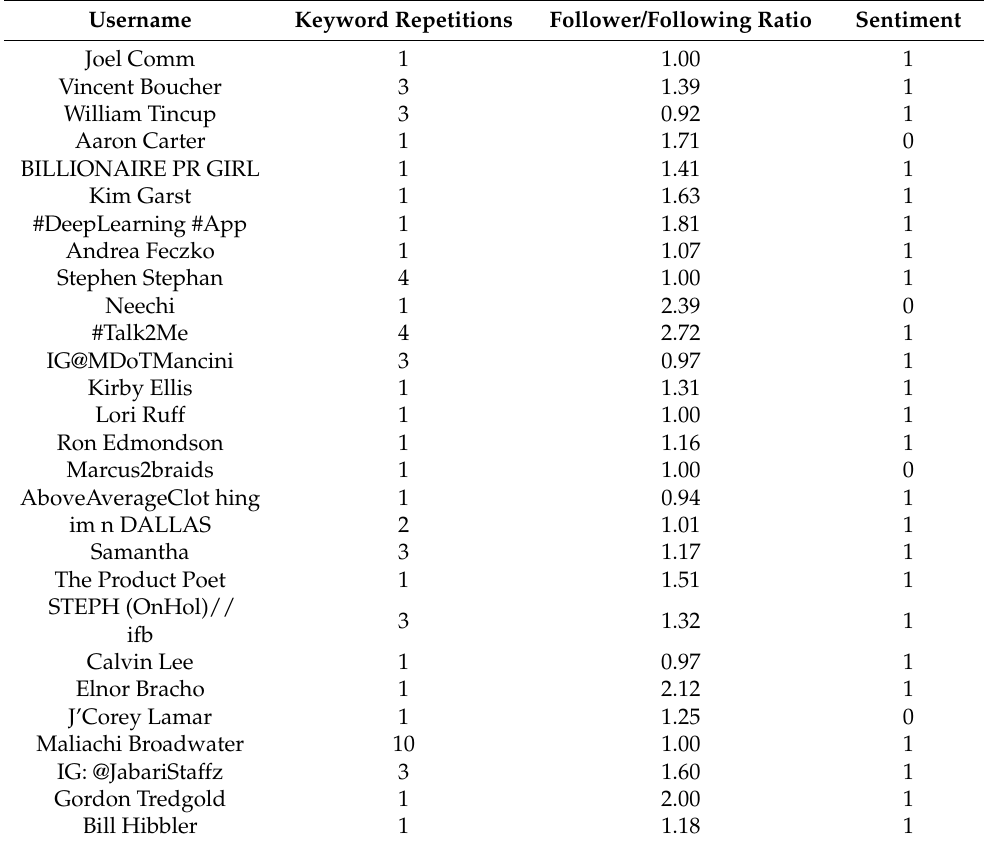
Table 4. AIRC Sentiment Analyzer Result [17].